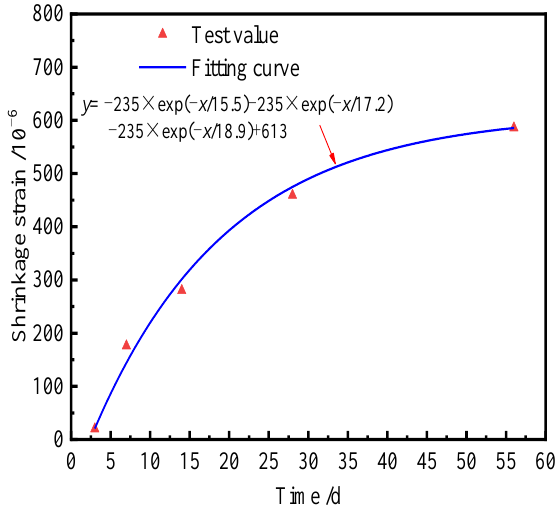
Figure 4. Shrinkage strain of CA mortar.